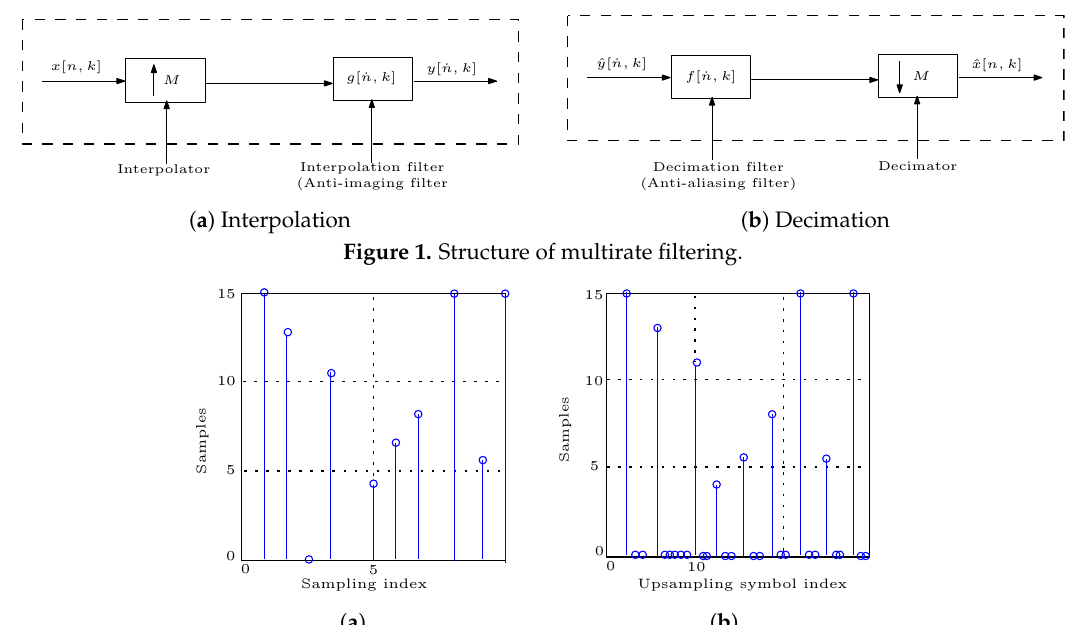
Figure 1. Structure of multirate filtering.